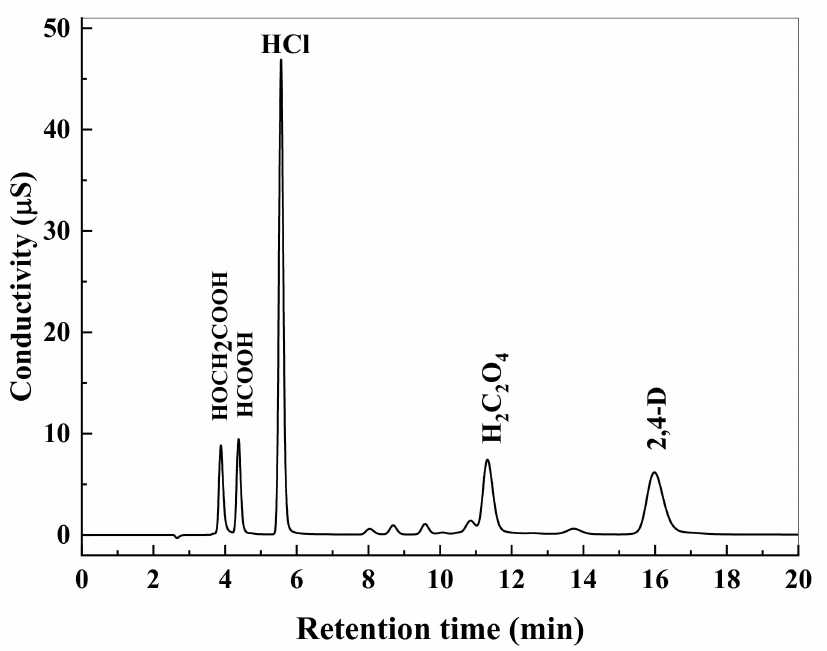
Figure 11. IC chromatogram of the RFD of 1.0 mM 2,4-D in pure water (input power, 200 W; discharge time, 40 min).